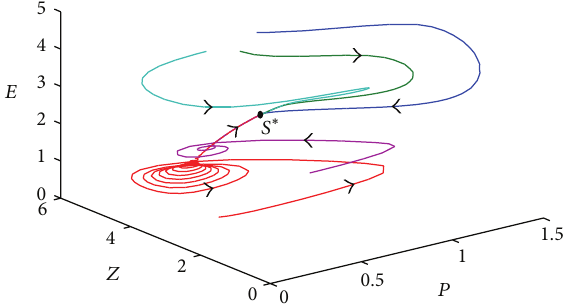
Figure 6: The optimal equilibrium 𝑆 ∗ (0.676, 3.871, 2.227) is stable with different initial